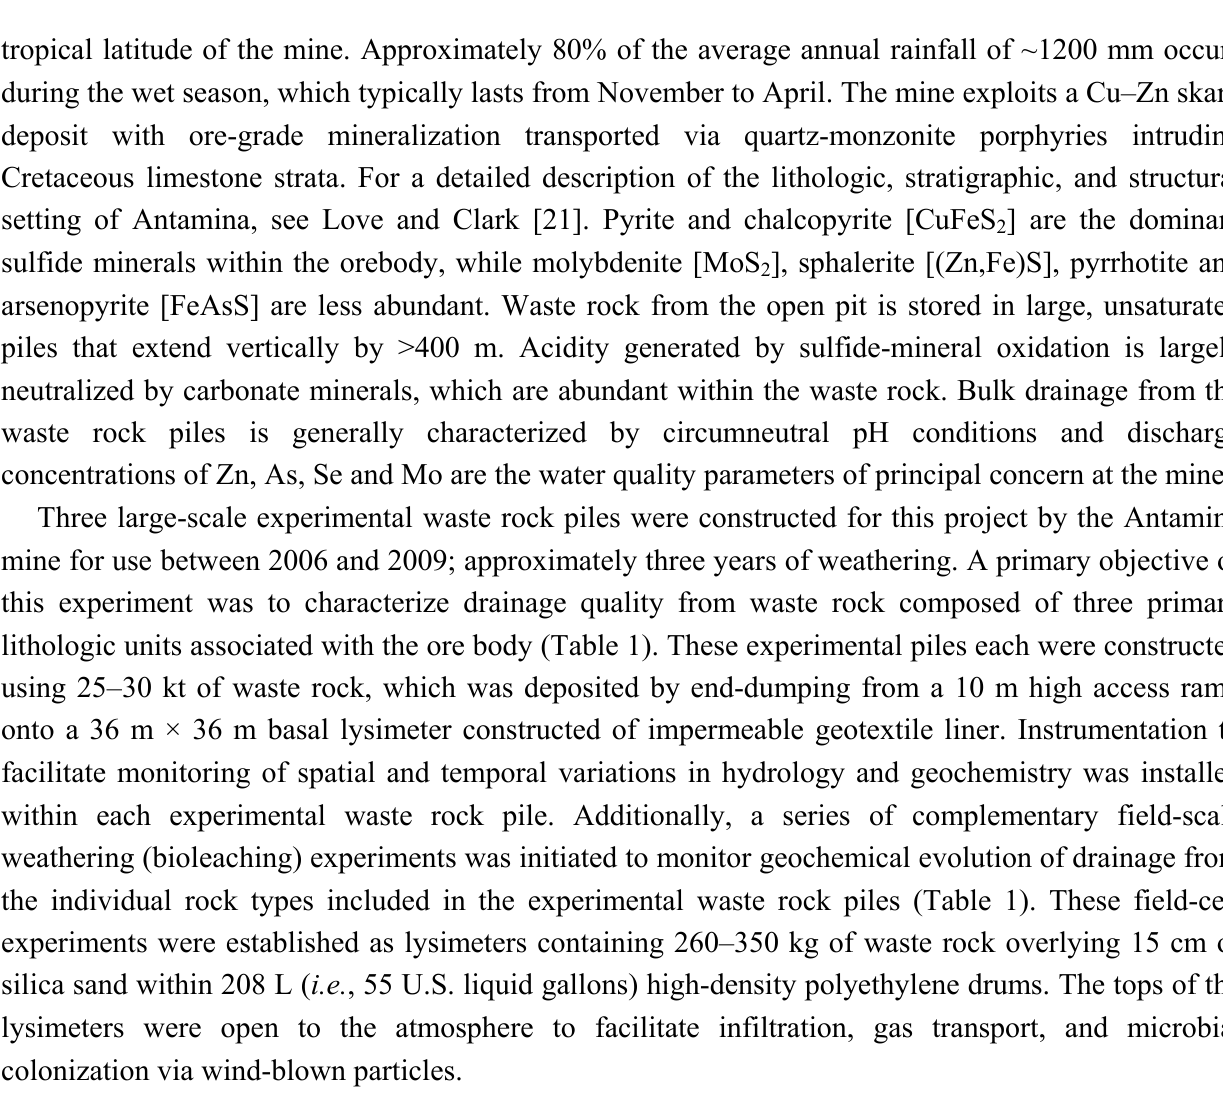
Table 1. Summary of average drainage pH and calculated cumulative mass discharges for July 2008–June 2009. Weathering duration indicates number of years since initiating the experiment. Parameters with values < 0.1 mg∙kg −1 were not